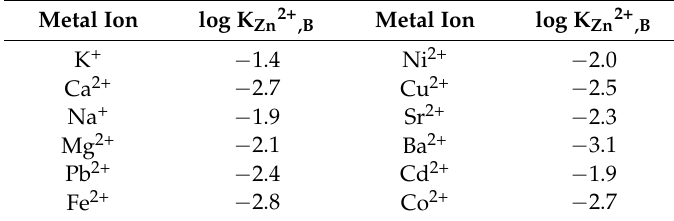
Table 3. Potentiometric selectivity coefficient values for DPA electrode by fixed interference method.